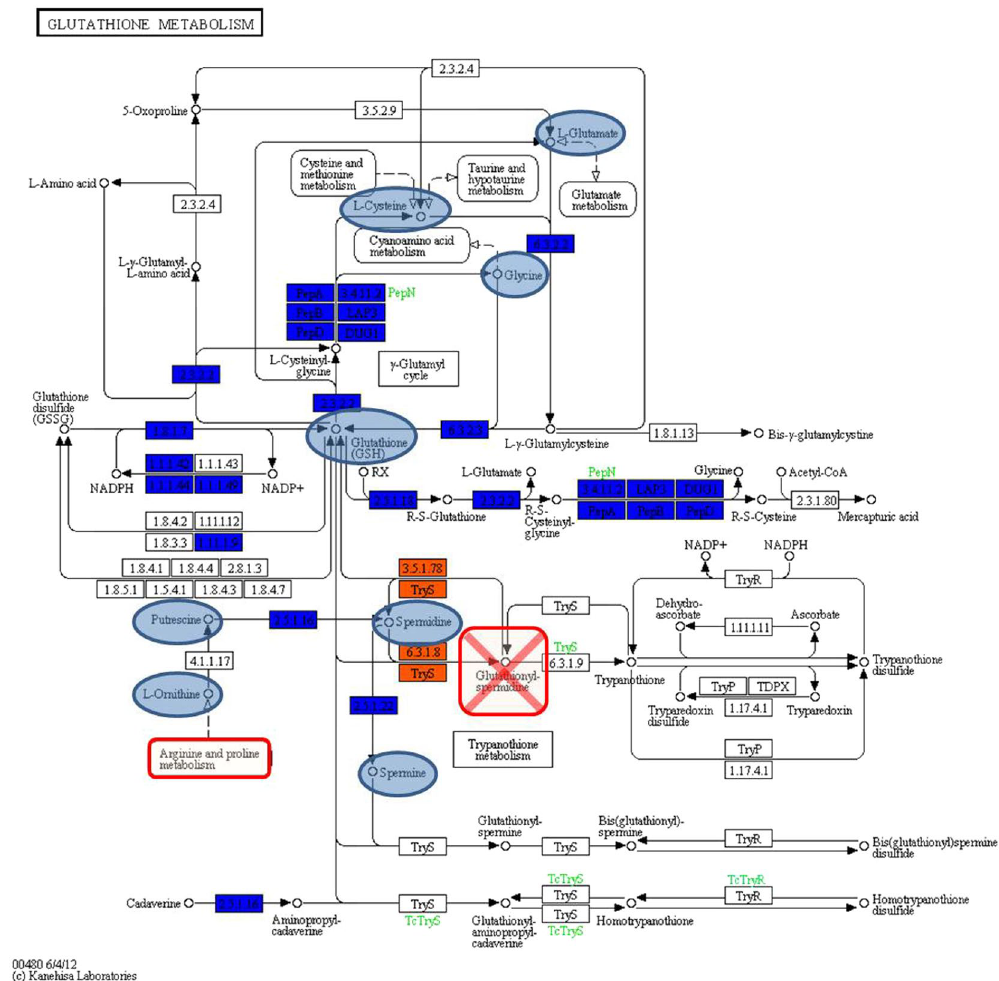
circles represent compounds. Core reactions are colored blue, variable reactions are colored orange; blue circles represent compounds better used by PhTAC125 at 4 °C, compared to PspTB41. The orange reactions indicates that PspTB41 is not able to carry out reactions catalyzed by glutathionylspermidine amidase/ synthetase (3.5.1.78) and glutathionylspermidine synthase (6.3.1.8), resulting in its inability on producing glutathionylspermidine and S-thiolation. Gluathione metabolism is strictly related to ‘Arginine and Proline